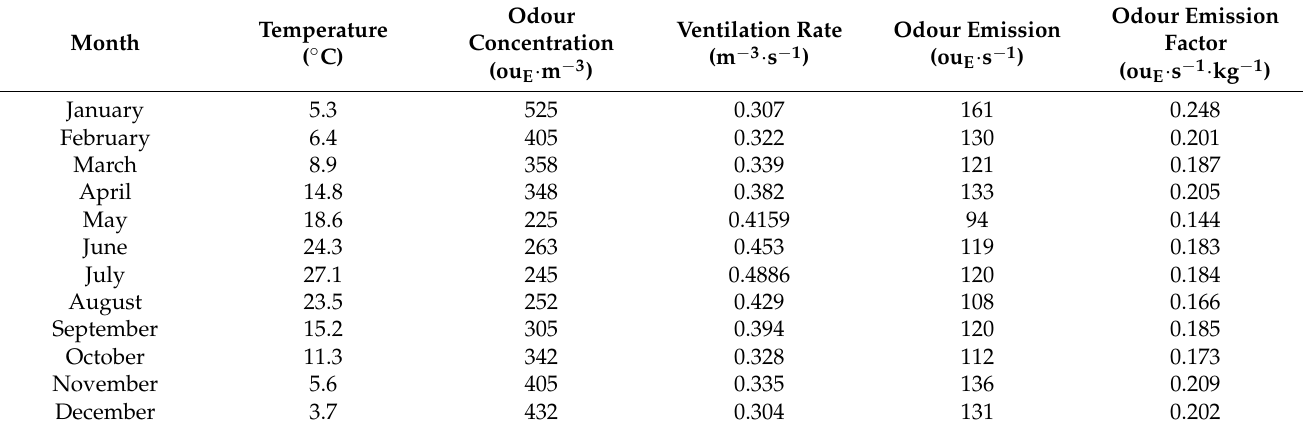
Table 4. Mean odour concentration and odour emission factor for dairy